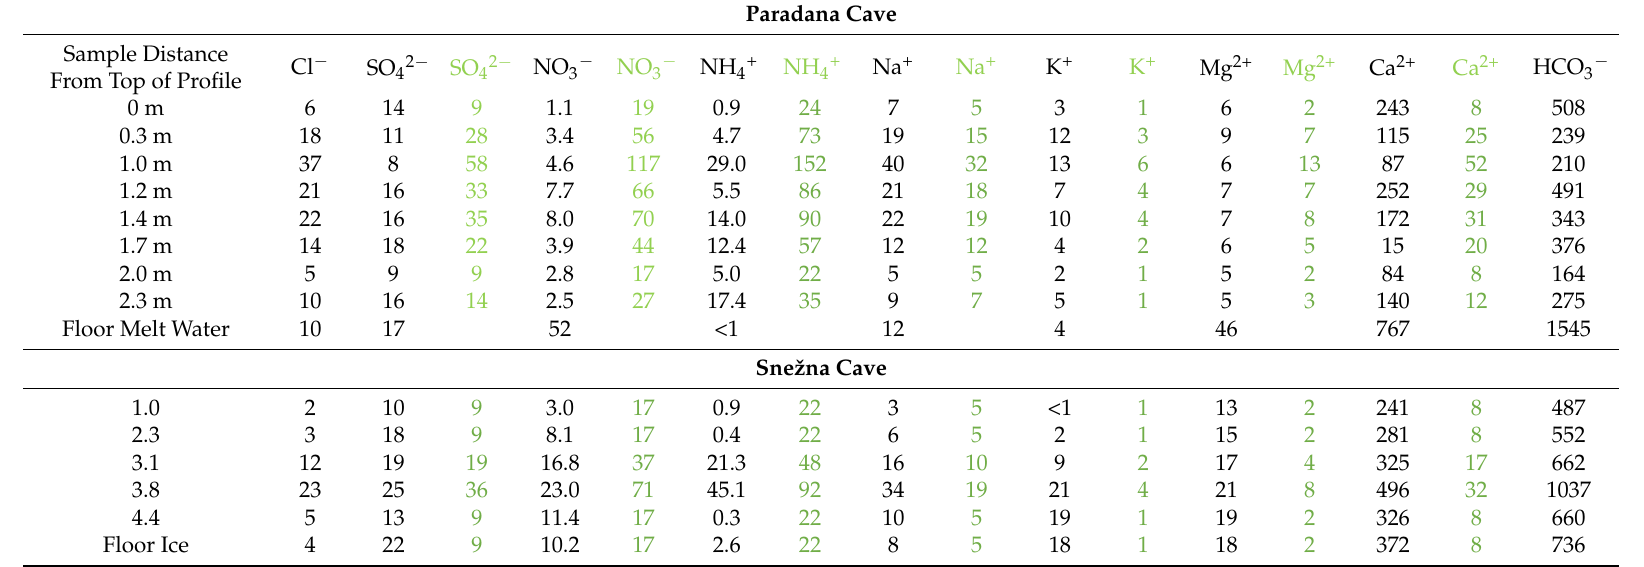
Table 1. Measured concentrations of major ions in Paradana Cave and Snežna Cave ice cave samples in µ M. Values in green represent values calculated using model described in the